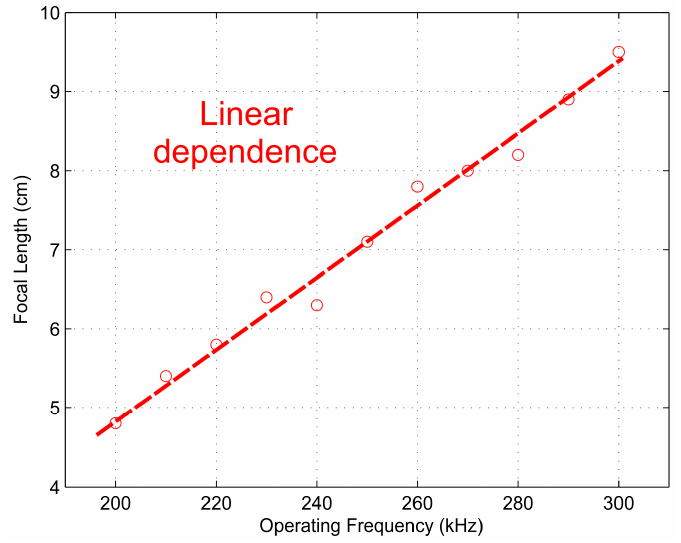
Figure 10. Measured focal length against operating frequency.